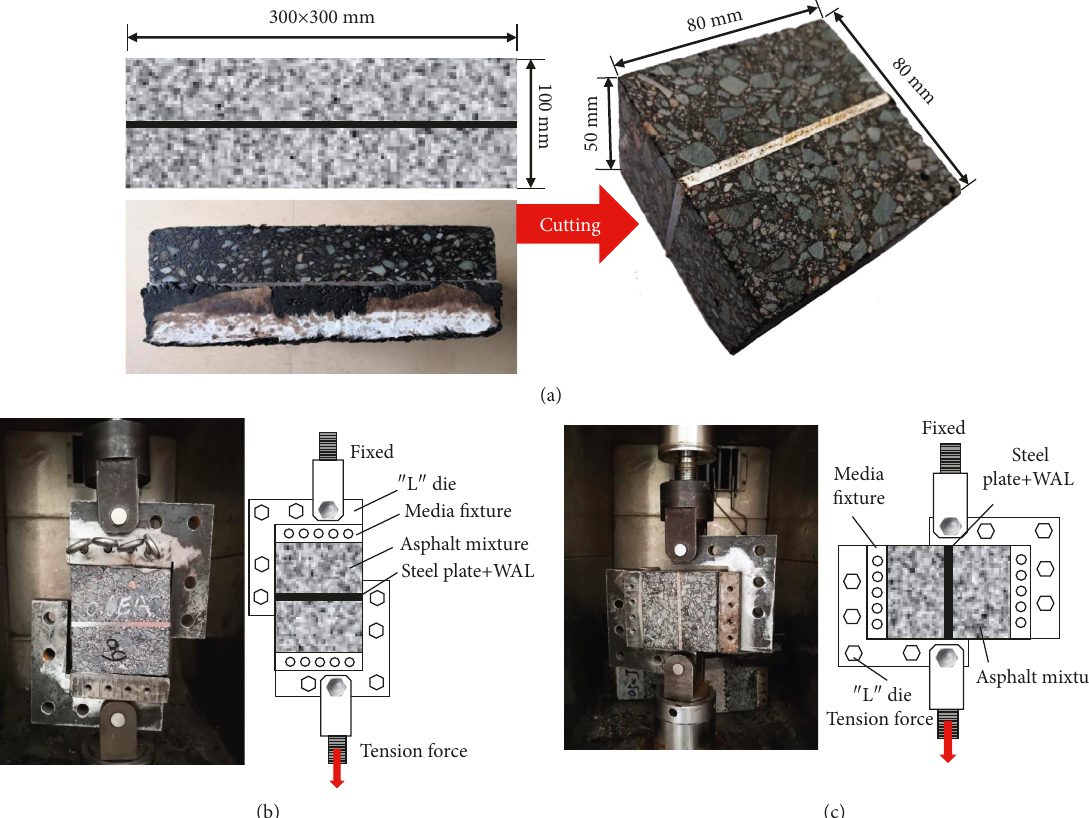
Figure 4: Testing sample and testing machine. (a) Preparation process, (b) pull-off test, and (c) direct-shear